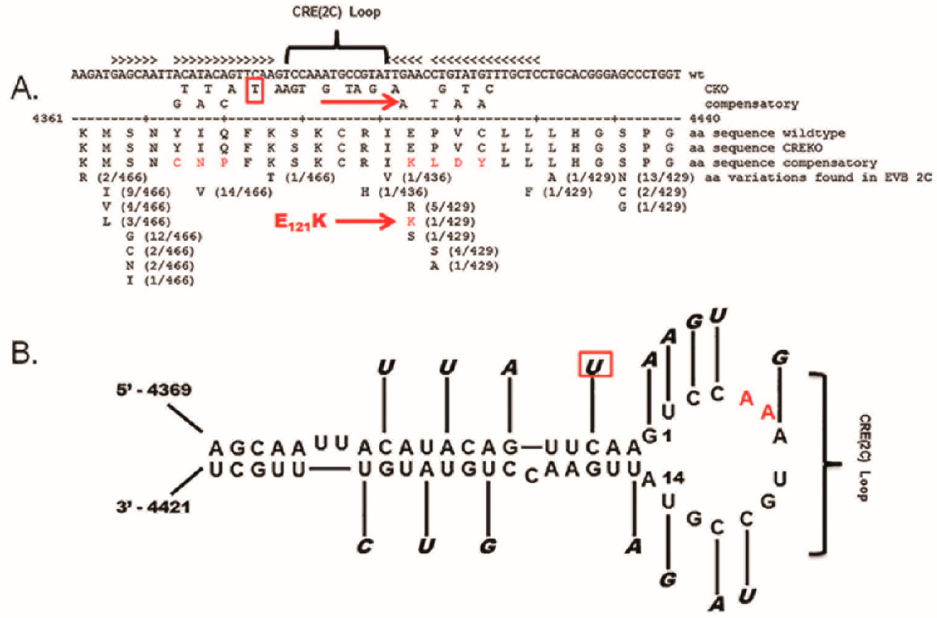
Figure 6. Compensatory mutations are unlikely in the stem of the CRE-2C. ( A ) Sequence analysis using NCBI was used to explore the possibility of compensatory mutations in the CRE-2C of CVB3. Potential amino acid variations resulting from compensatory mutations to restore the CRE-2C RNA structure are noted. All variations in the CRE-2C-encoding sequence that would affect the amino acid sequence of the 2C protein are noted. Only 1 amino acid variation identical to those resulting from compensatory mutations was reported to exist in 429 EV-B 2C aa sequences examined (box and arrows). ( B ) Location of this compensatory mutation in the CRE-2C secondary structure (box). Reprinted with permission [77], 2016, Elsevier.